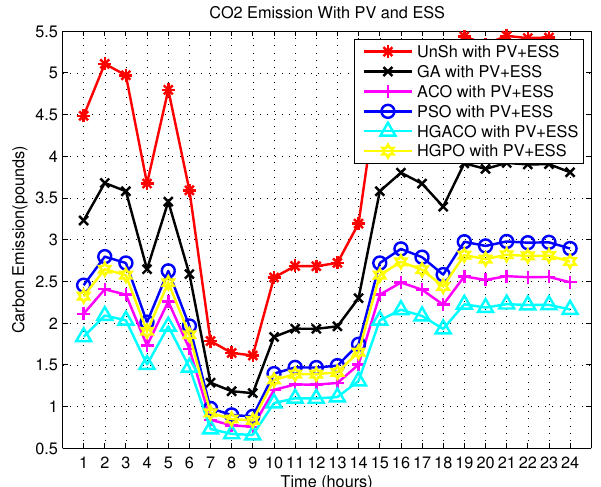
Figure 20. Scenario III: carbon emission with photovoltaic-battery systems.